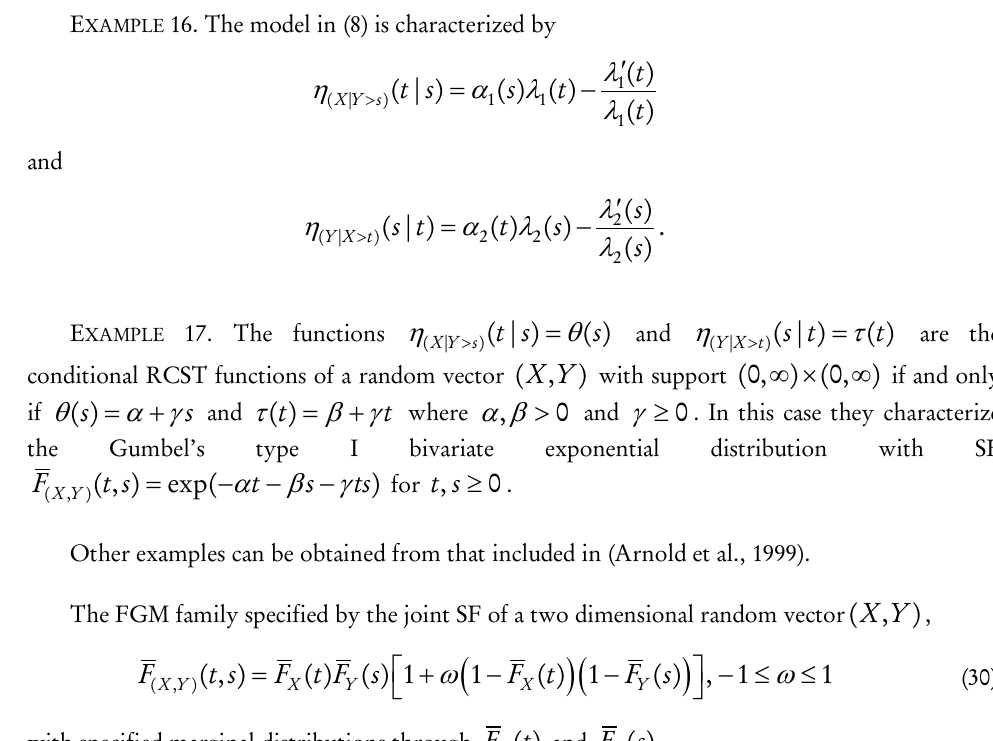
with specified marginal distributions through